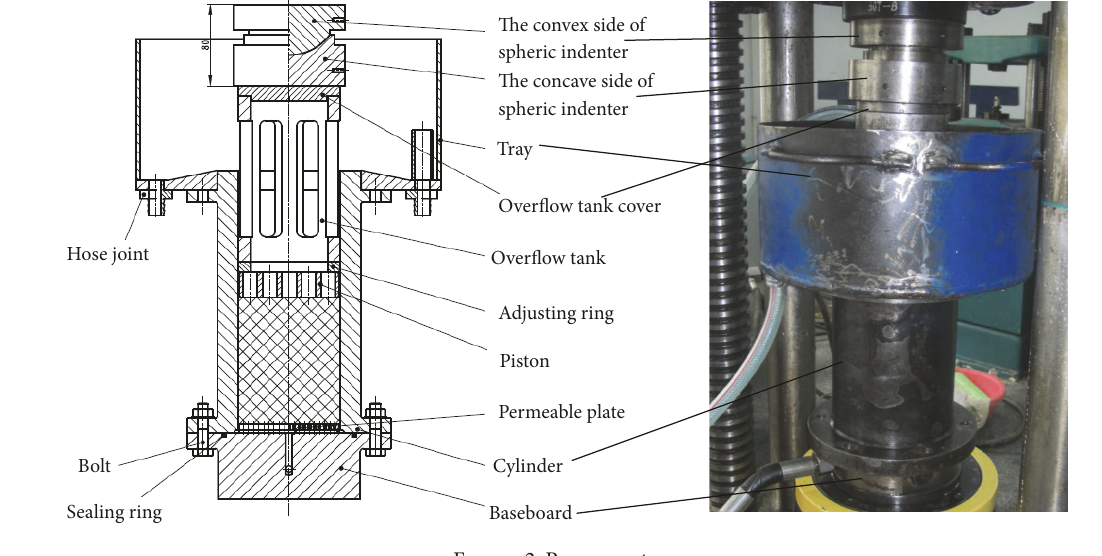
Figure 2: Permeameter. Table 1: Mass (g) distribution of particles with different